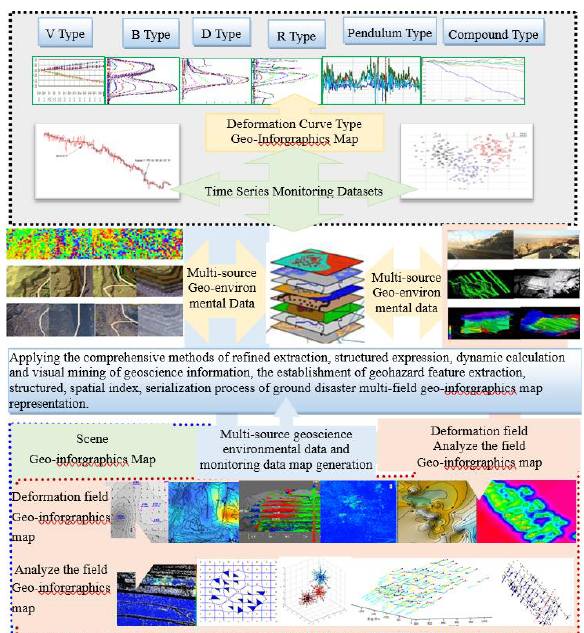
Figure 10. Types, shapes and data relationships of Geo-inforgraphics Map of Geohazards in mining